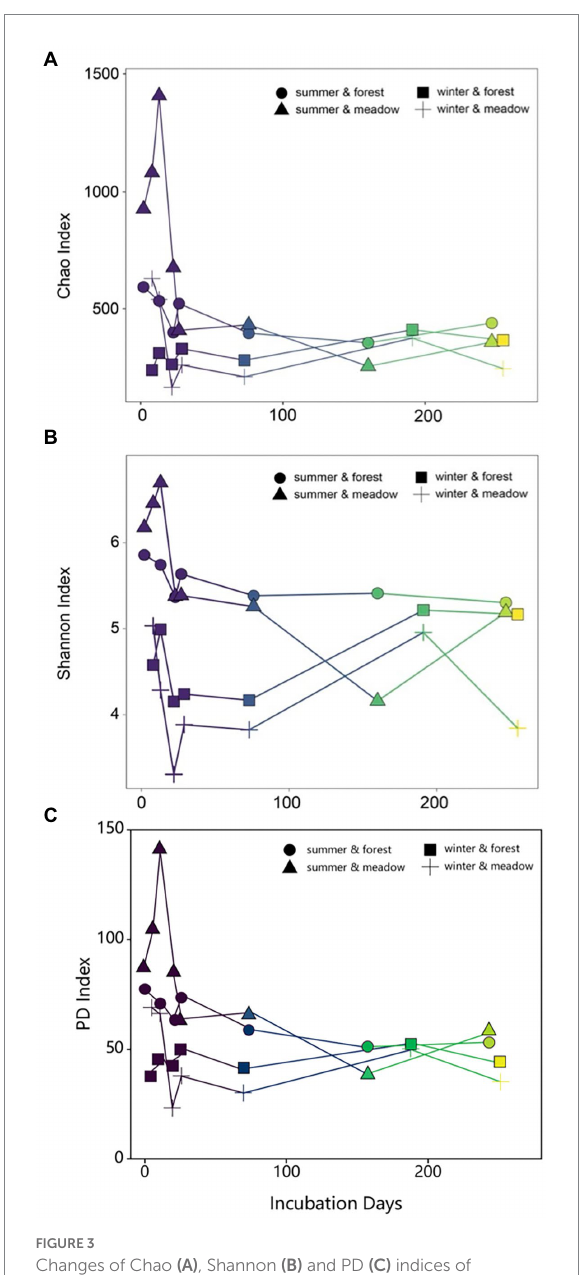
FIGURE 3 Changes of Chao (A) , Shannon (B) and PD (C) indices of periphyton communities during the